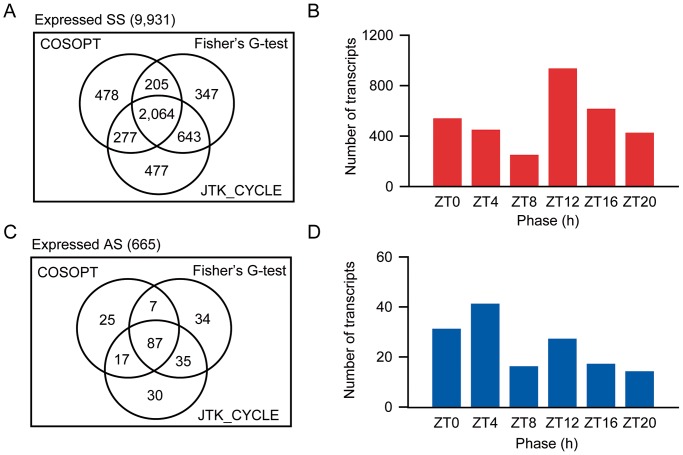
Identification of rhythmic sense and antisense transcripts in sugarcane.(A) Venn diagram showing the number of sense probes that were considered expressed and were considered rhythmic by three algorithms: JTK_CYCLE, COSOPT and Fisher's G-test. Probes identified as rhythmic in at least two algorithms were considered circadian. (B) Phase distribution of rhythmic sense probes. The phase of each rhythmic probe was estimated using JTK_CYCLE and binned in 6 groups, according to the time of their peak. (C) Venn diagram showing the number of antisense probes that were considered expressed and considered rhythmic by three algorithms: JTK_CYCLE, COSOPT and Fisher's G-test. (D) Phase distribution of circadian antisense probes.